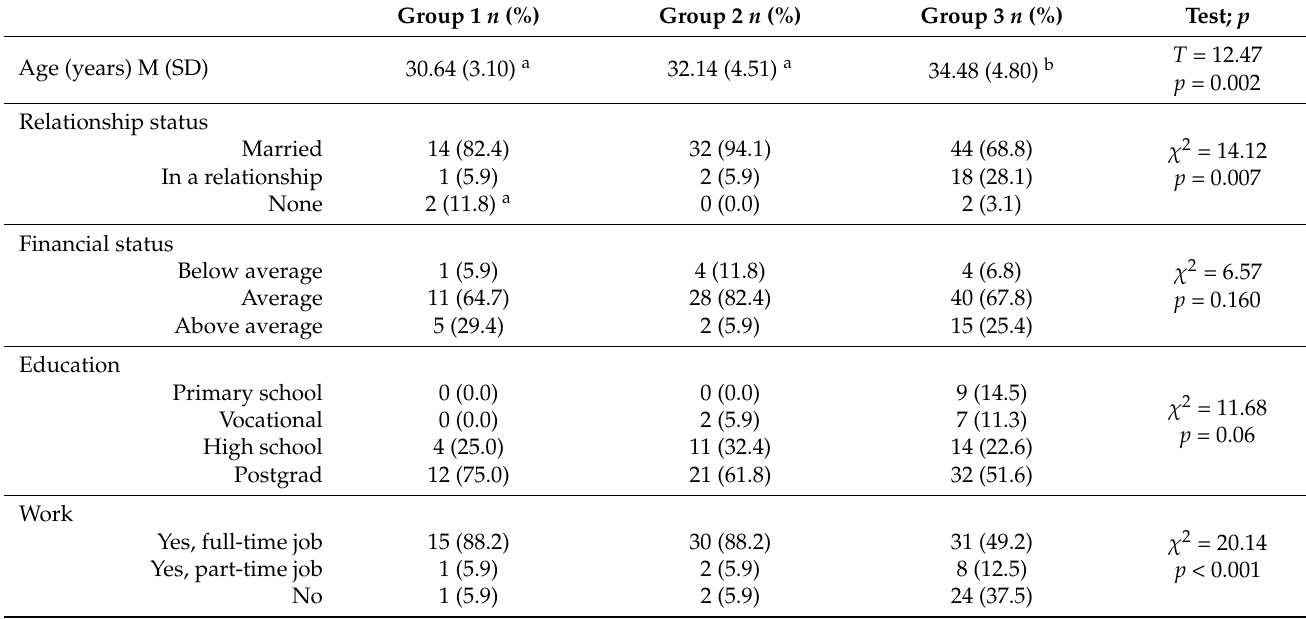
Table 1. Sociodemographic characteristics of the participants ( n =